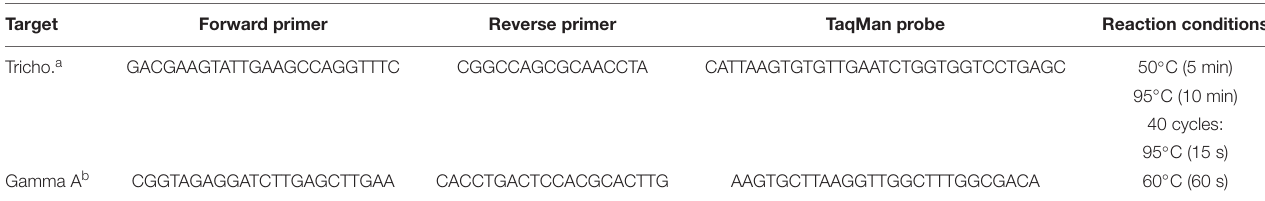
TABLE 1 | Quantitative PCR primers, probes and reaction conditions for two nifH OTUs targeted during this study. Target Forward primer Reverse primer TaqMan probe Reaction conditions Tricho.